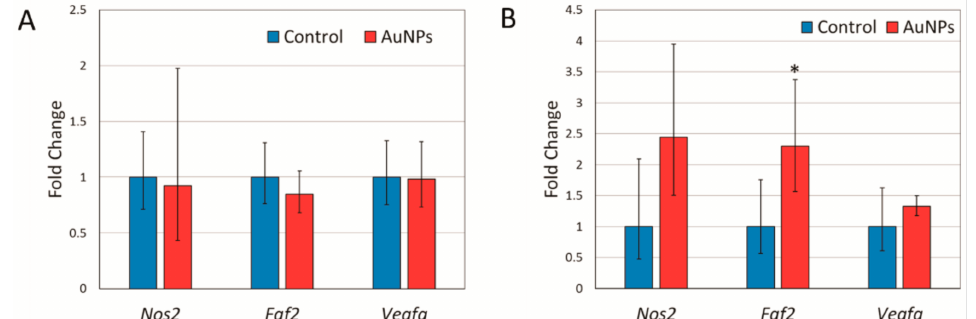
Figure 3. Expression of Nos2 , Fgf2, and Vegfa at mRNA level in tumors from mice treated with AuNPs intragastrically ( A ) and intravenously ( B ). Data are expressed as means and 95% confidence intervals from six animals. * p < 0.05 difference versus control group.